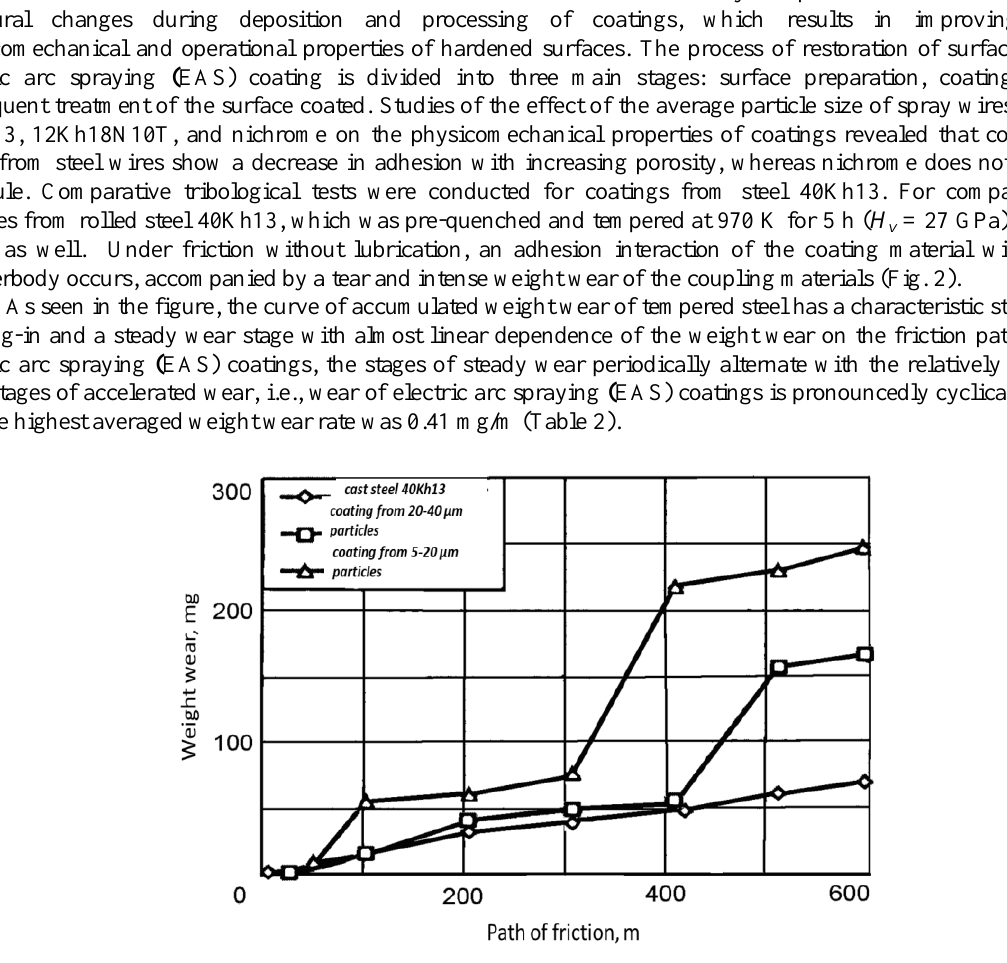
Fig. 2. Dependence of the weight wear on the friction path for electric arc spraying coatings from steel 40Kh13 (friction without lubrication, pressure 1.5 MPa, counterbody from hardened steel